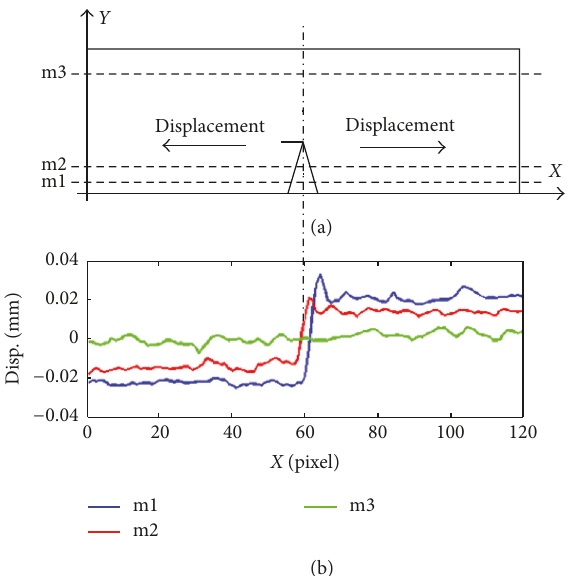
Figure 3: (a) Schematic diagram of SENB specimen under three- point bending showing the positions of Paths m1, m2, and m3; (b) horizontal displacement along Paths m1, m2, and m3.